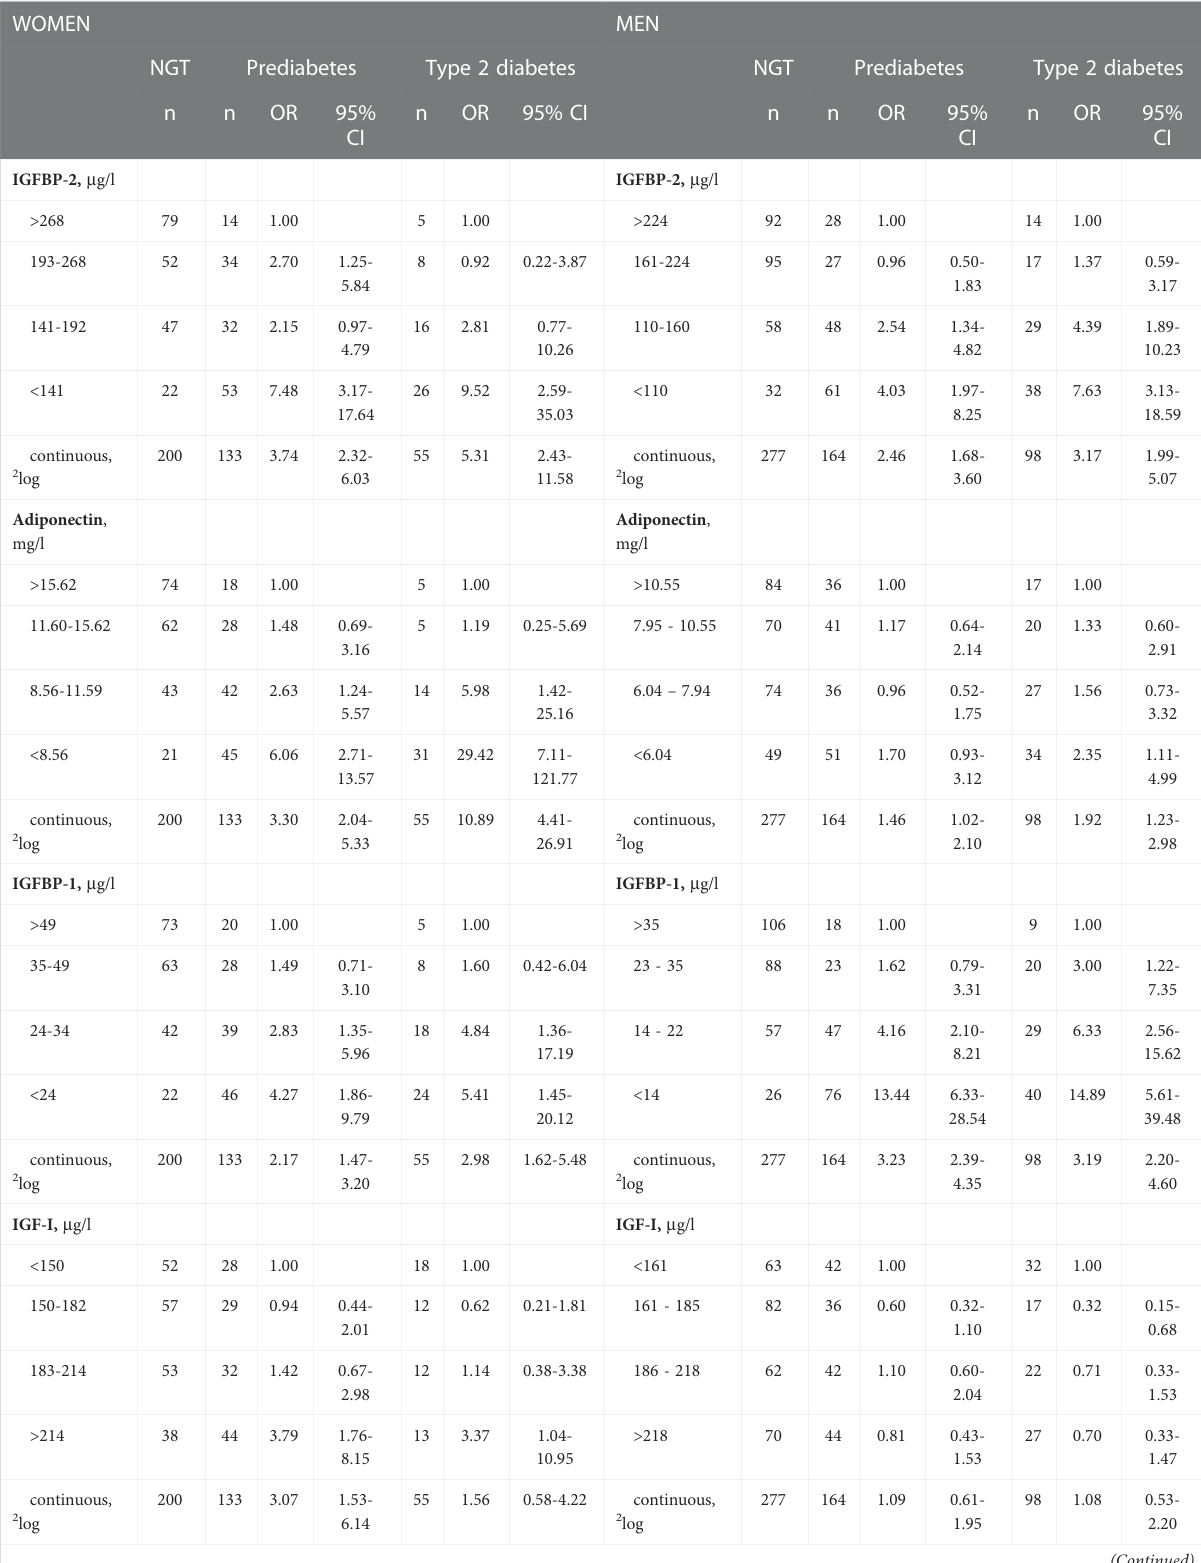
TABLE 2 Odds ratios (ORs) for decreasing baseline values of IGFBP-2, adiponectin and IGFBP-1 and increasing baseline values of IGF-I and IGF-II in subjects having normal glucose tolerance (NGT) at baseline in the association to development of prediabetes and type 2 diabetes at follow-up compared to remaining